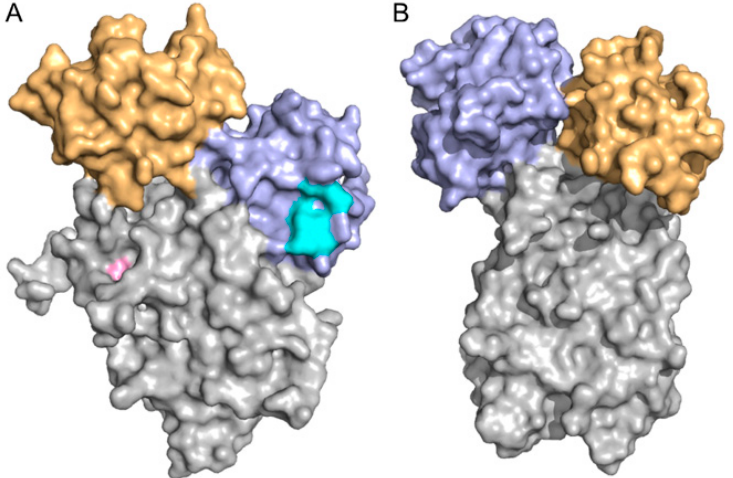
Figure 6. ( A ) SHP1 in auto-inhibitory conformation (PDB ID: 2B3O). Thr80, Gln81, and Lys97 are shown in cyan. Asn472 is shown in pink. ( B ) SHP2 in open conformation (PDB ID: 6CRF). N-SH2, C-SH2, and PTP domains are shown in blue, orange and gray, respectively.